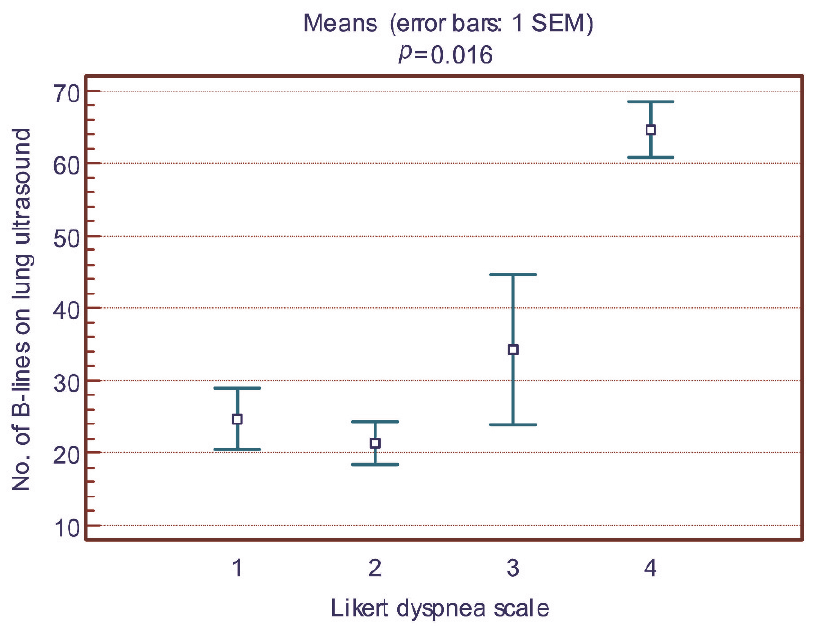
Figure 2 - Number of B-lines estimated by lung ultrasound in patients with different dyspnea scores measured by the 5-point Likert scale for dyspnea. ANOVA: p =0.016. The Student-Newman-Keuls test for all pairwise comparisons revealed a difference between those patients who had a score of 4 on the 5-point Likert scale for dyspnea and those with other scores ( p , 0.05).